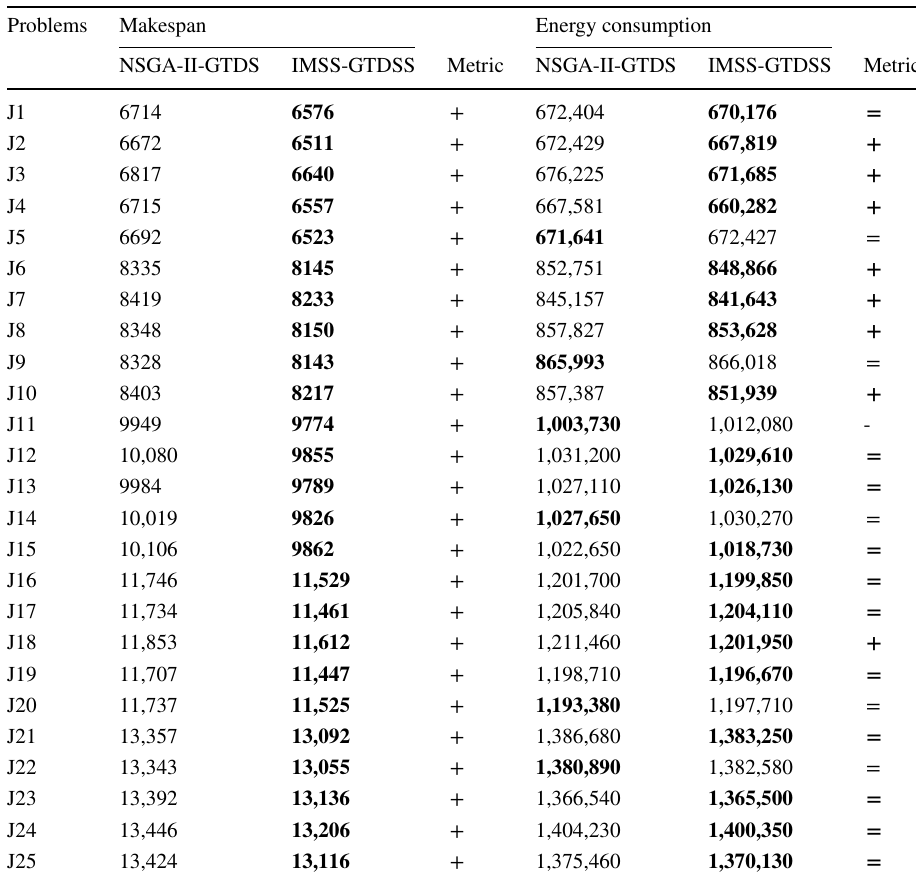
Table 4 The average energy consumption and the average makespan obtained by NSGA- II-GTDSS and IMSS-GTDSS